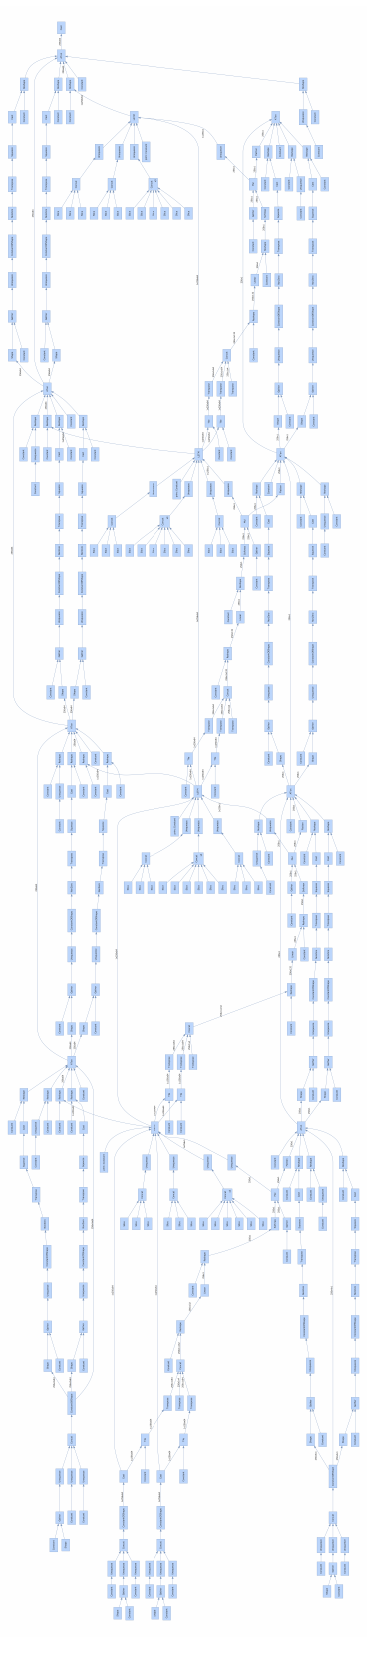
Figure 3. The neural network structure of the encoder of